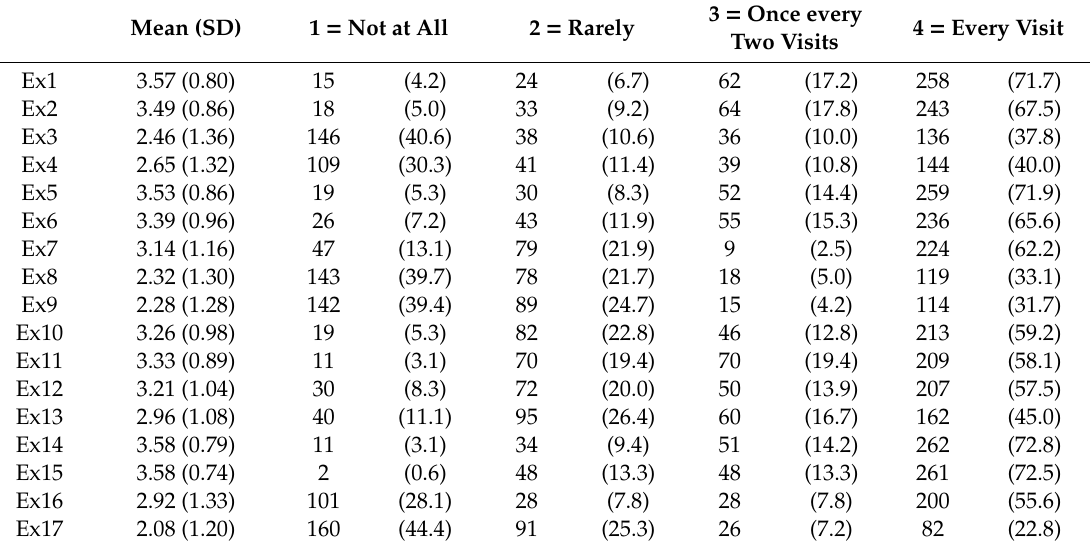
Table 2. Frequency of clients’ / family members’ experiences in adult day care service